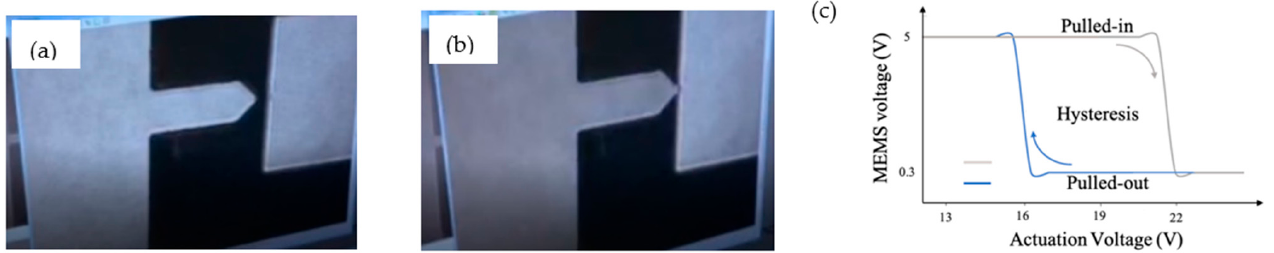
Figure 13. Pull out ( a ) and pull in ( b ) images for MEMS 3. ( c ) A sample hysteresis plot.